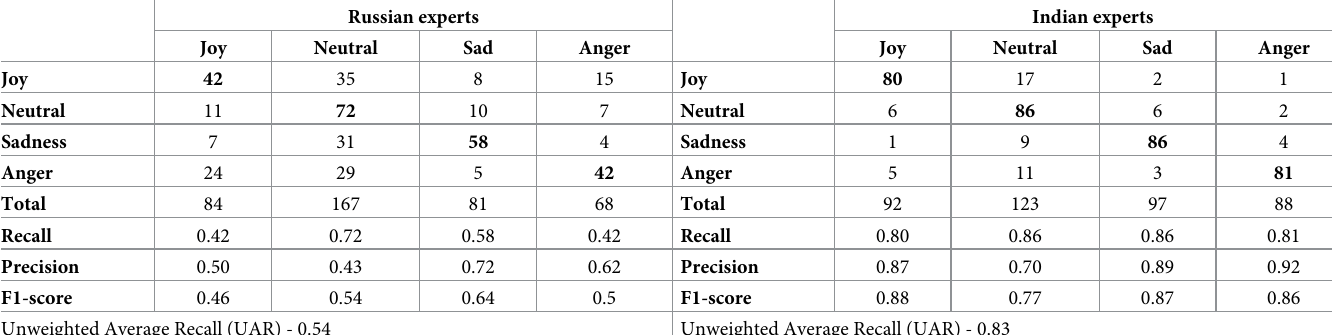
Table 5. Confusion matrix for emotion recognition in the spontaneous speech of Tamil speaking children by Russian and Indian experts. Russian